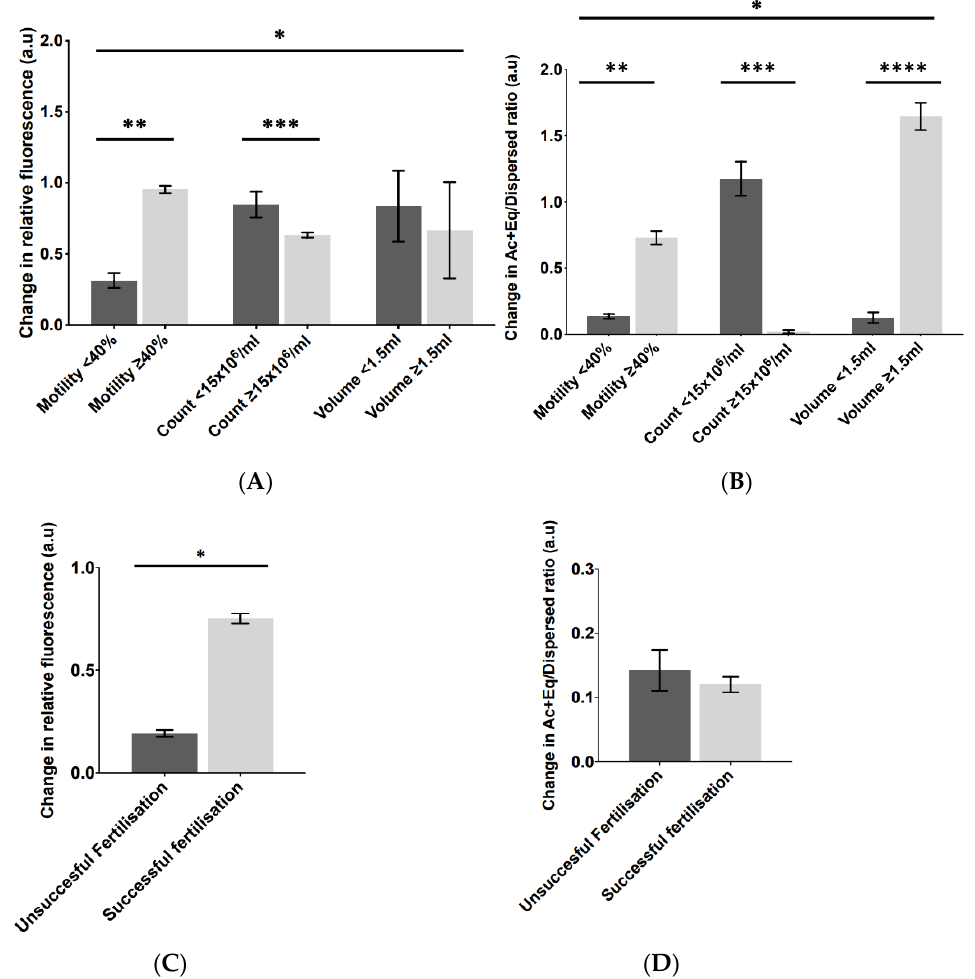
Figure 5. Representative indication of the change in ( A ) PLCζ fluorescence levels and ( B ) Ac + Eq/dispersed localisation ratios following AUM in non-optimal (dark bars) versus optimal (light bars) parameters of sperm motility (≥40%), sperm concentration (count ; ≥15 × 10 6 sperm/mL), and semen volume (1.5 – 5.5 mL). ( C ) PLCζ fluorescence levels and ( D ) Ac + Eq/dispersed localisation ratios following AUM in cases of unsuccessful fertilisation (dark bars) compared to cases of successful fertilisation (light bars). Asterisks (*, **, ***, ****) indicate a statistically significant ( p ≤ 0.05) difference. Data are indicative of 100 cells examined from 55 patients each (550 cells). a.u.: arbitrary units.